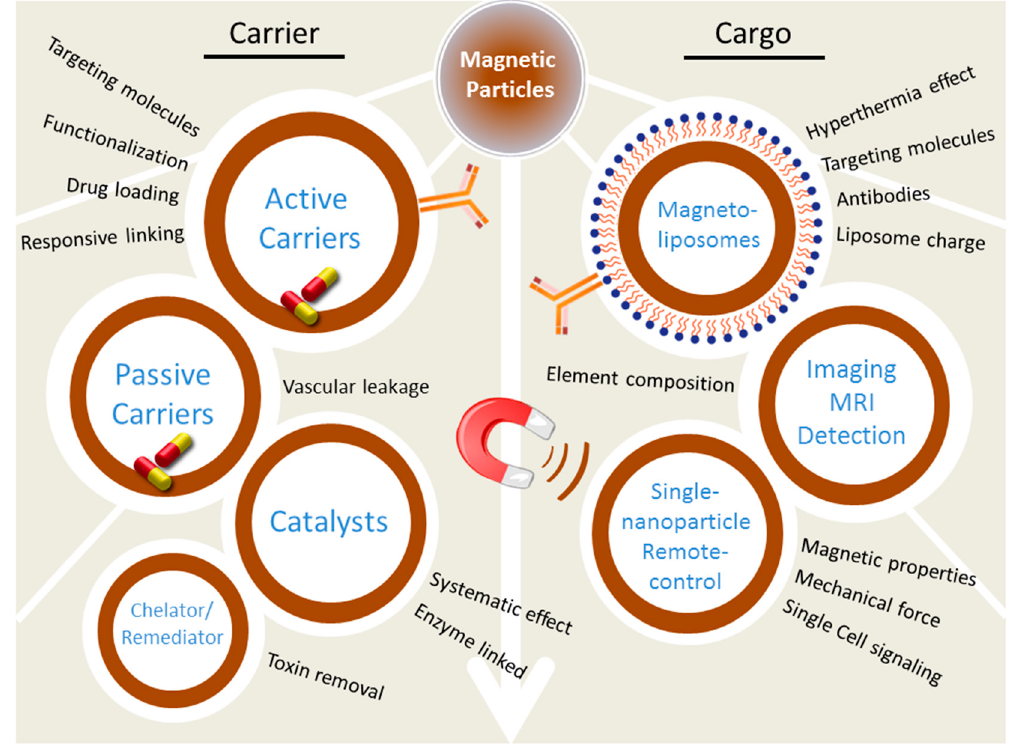
Figure 1. The scheme of magnetic particles utilization. MRI: magnetic resonance imaging.